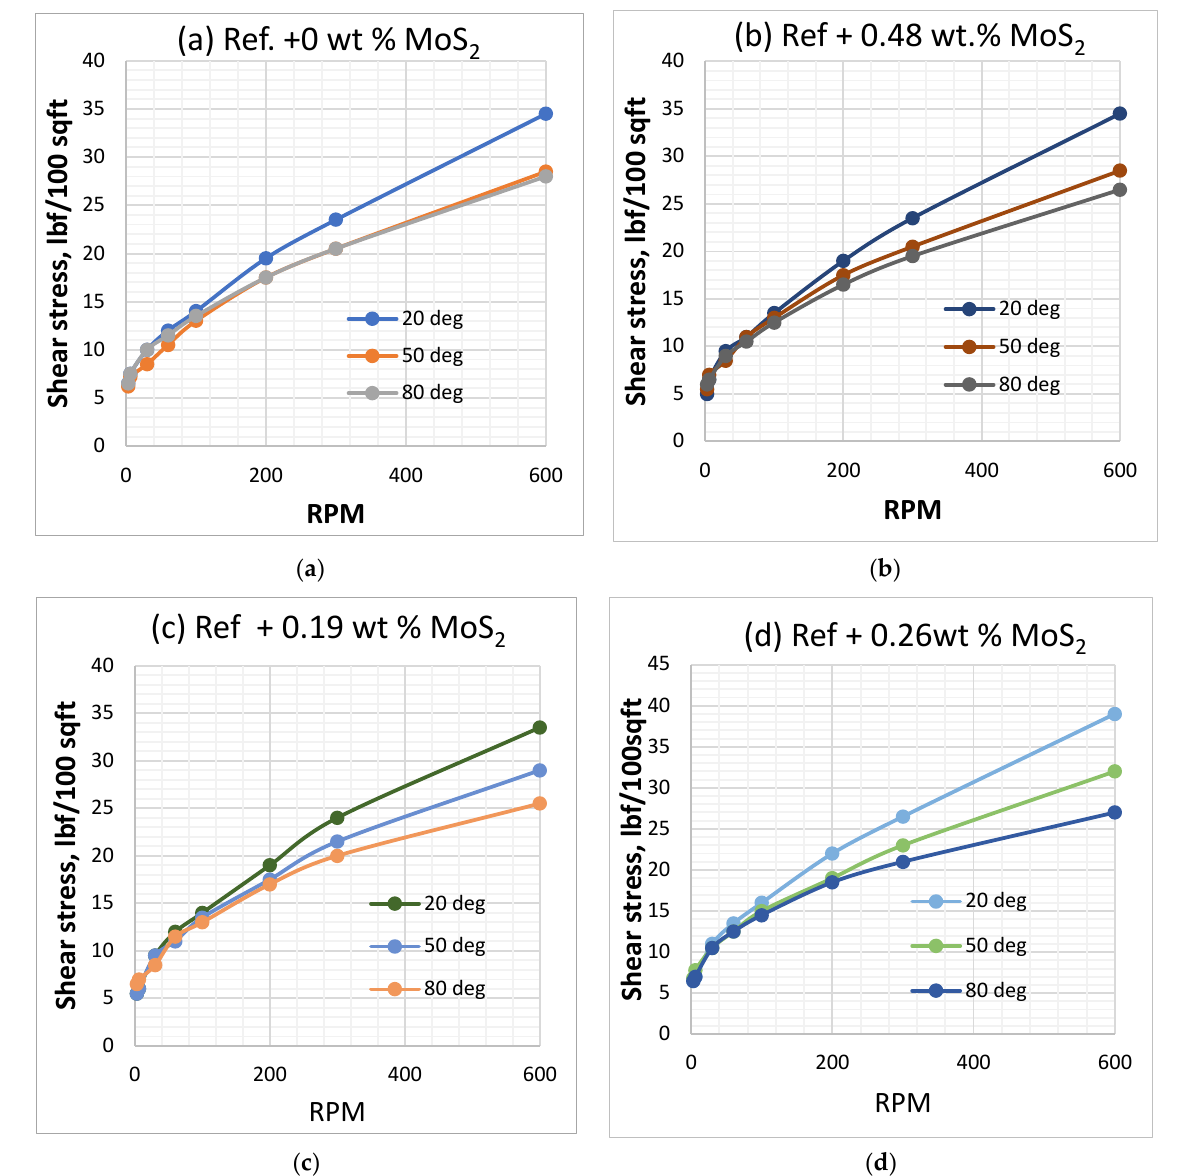
Figure 1. VG meter response of drilling fluids measured at (22 °C, 50 °C and 80 °C). ( a ) Reference-based fluid, ( b ) 0.09 wt.% MoS 2 blended fluid, ( c ) 0.19 wt.% MoS 2 blended fluid, ( d ) 0.26 wt.% MoS 2 blended fluid.